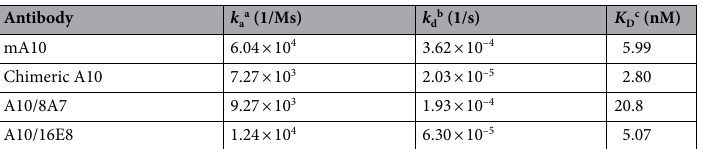
Table 1. Kinetic parameters of mA10, chimeric A10, A10/8A7, and A10/16E8 obtained by SPR analysis. a Abbreviation: